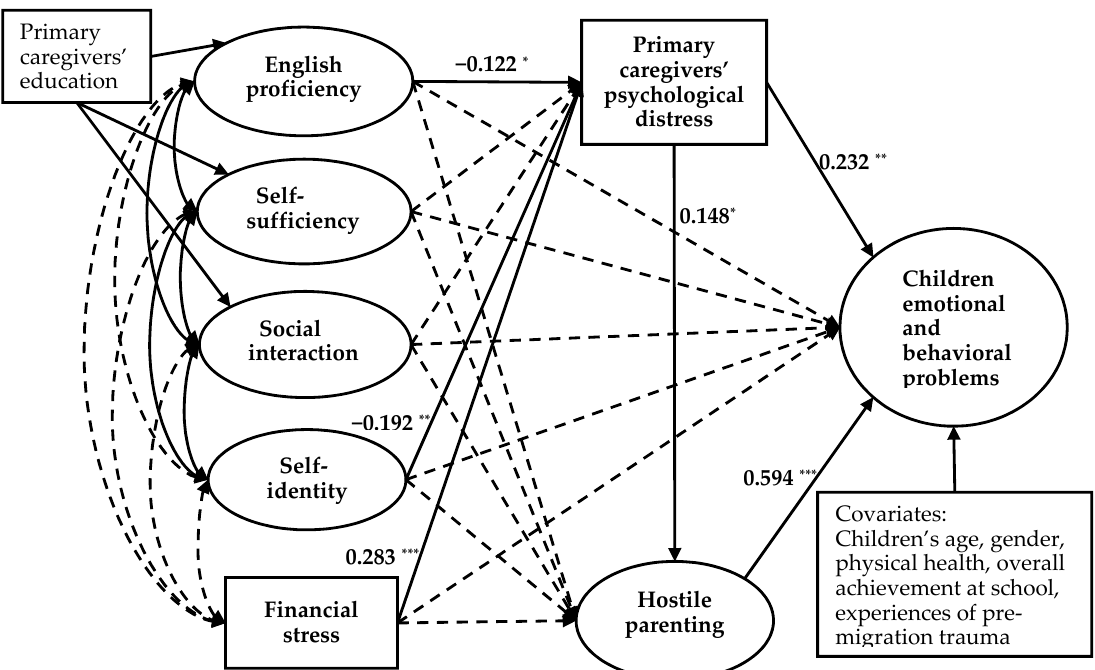
Figure A1. Basic FSM. Note . ** p < 0.01, *** p < 0.001. Coefficients are standardized path coefficients. The solid lines represent significant paths ( p < 0.05). The dashed lines represent non-significant paths. Children’s age, gender, physical health, overall achievement at school, and experiences of pre- migration trauma are included as covariates. Model fitting indices:  (cid:2870) (105) = 252.861, p < 0.001, CFI = 0.875, TLI = 0.839, RMSEA = 0.046, SRMR = 0.079.